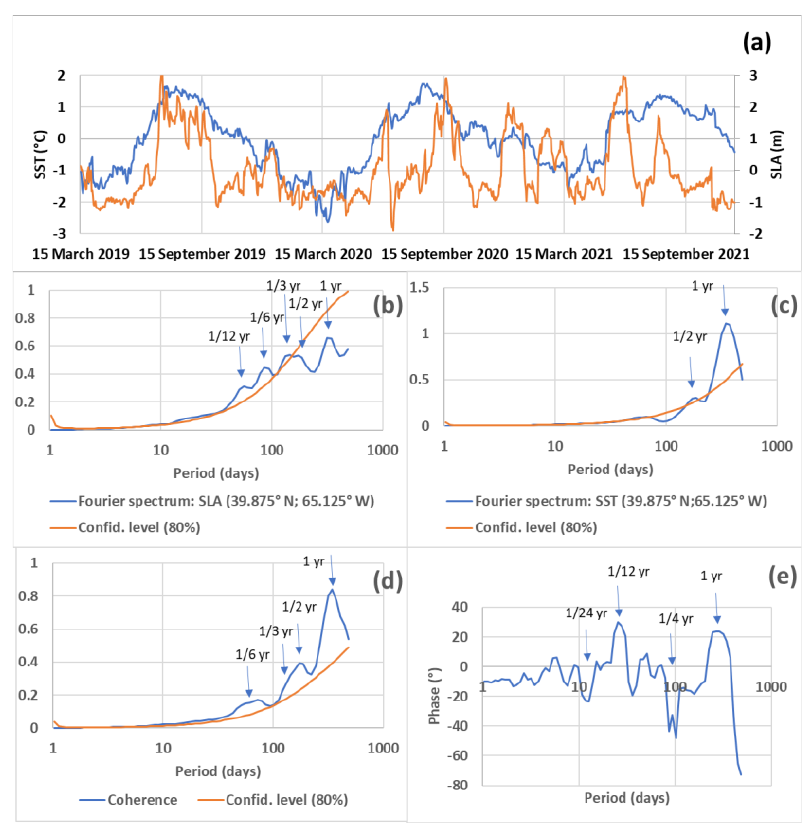
Figure 2. The sea level anomaly (SLA) in red and the sea surface temperature (SST) in blue at 39.875° N, 65.125° W: ( a ) the raw signals centered and reduced; ( b ) the Fourier spectrum and the main harmonics of SLA; ( c ) the Fourier spectrum and the main harmonics of SST; ( d ) the coherence spectrum of SLA and SST, and the main harmonics; ( e ) the phase spectrum of SLA and SST, and the main harmonics. To improve the readability of the figures, a confidence level of only 80% is used because only the position of the peaks is relevant, not their height.